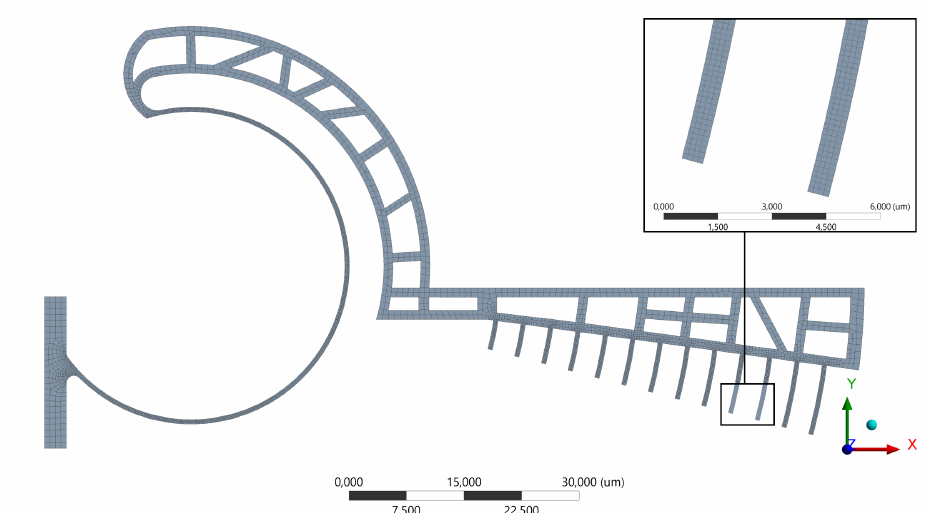
Figure 6. Second layout: mesh of the floating structure and detail of the comb-drive fingers.